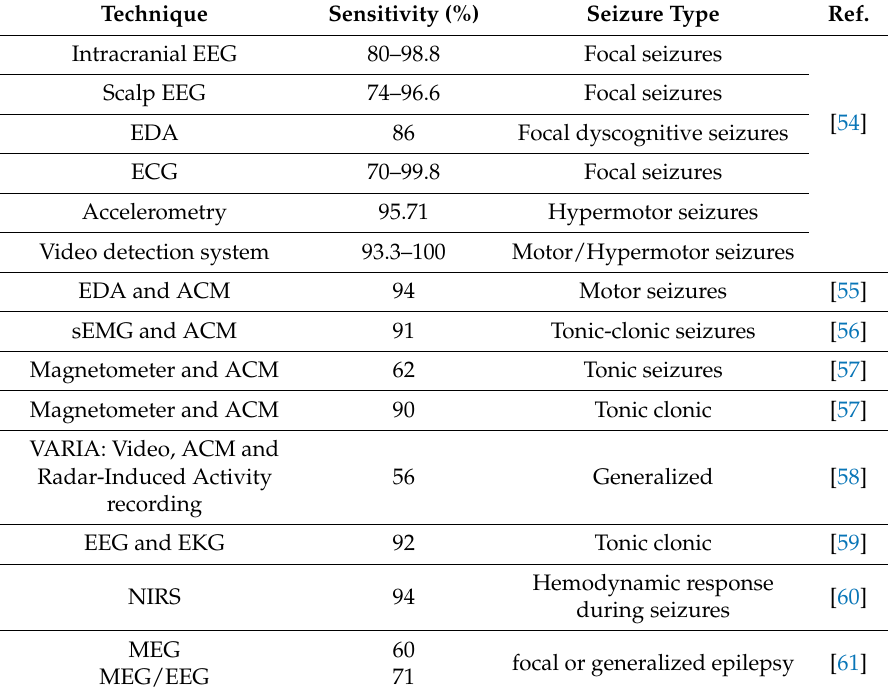
Table 2. Sensitivity of individual and multimodal systems for specific types of